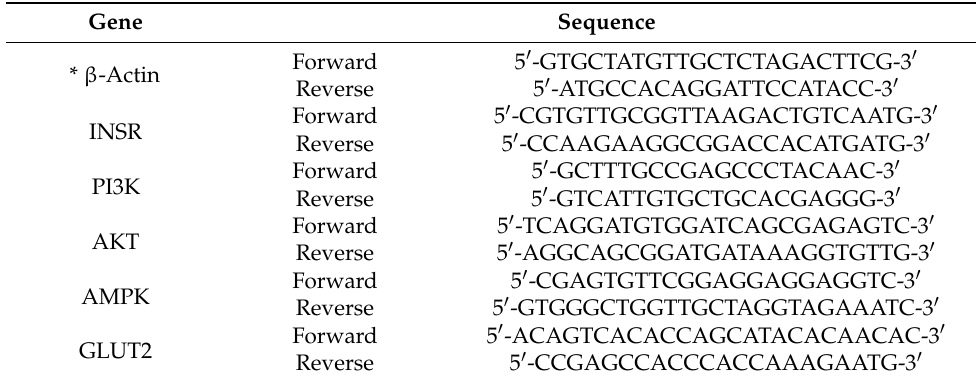
Table 1. Primer sequences for RT-qPCR